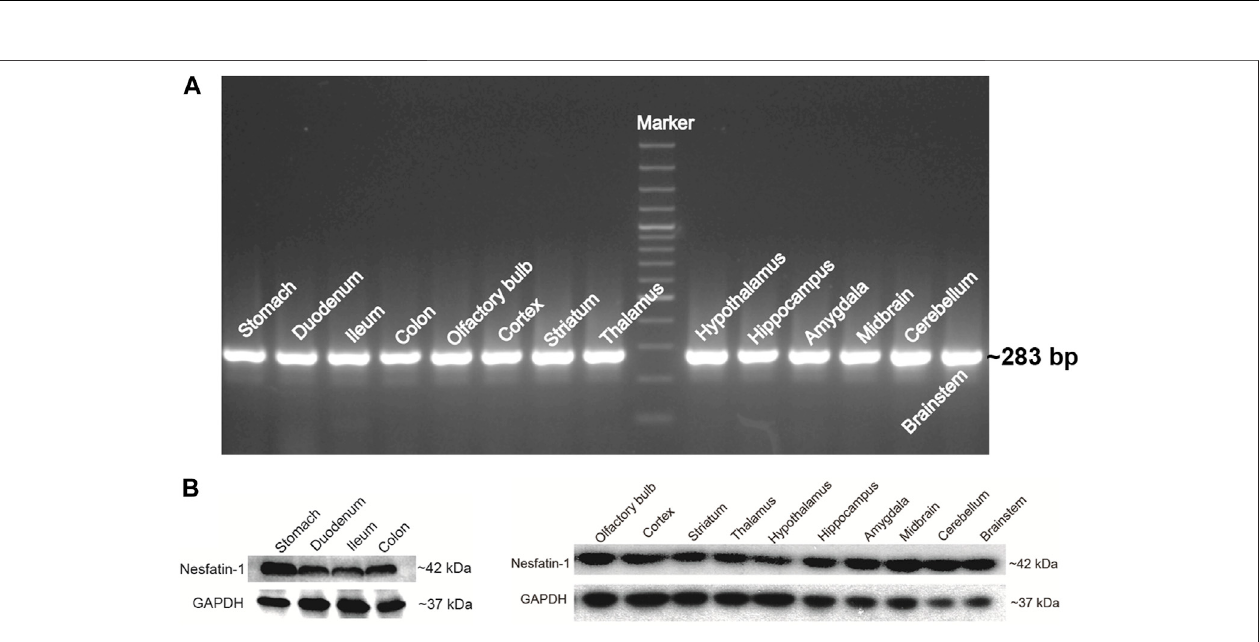
Frontiers in Pharmacology |